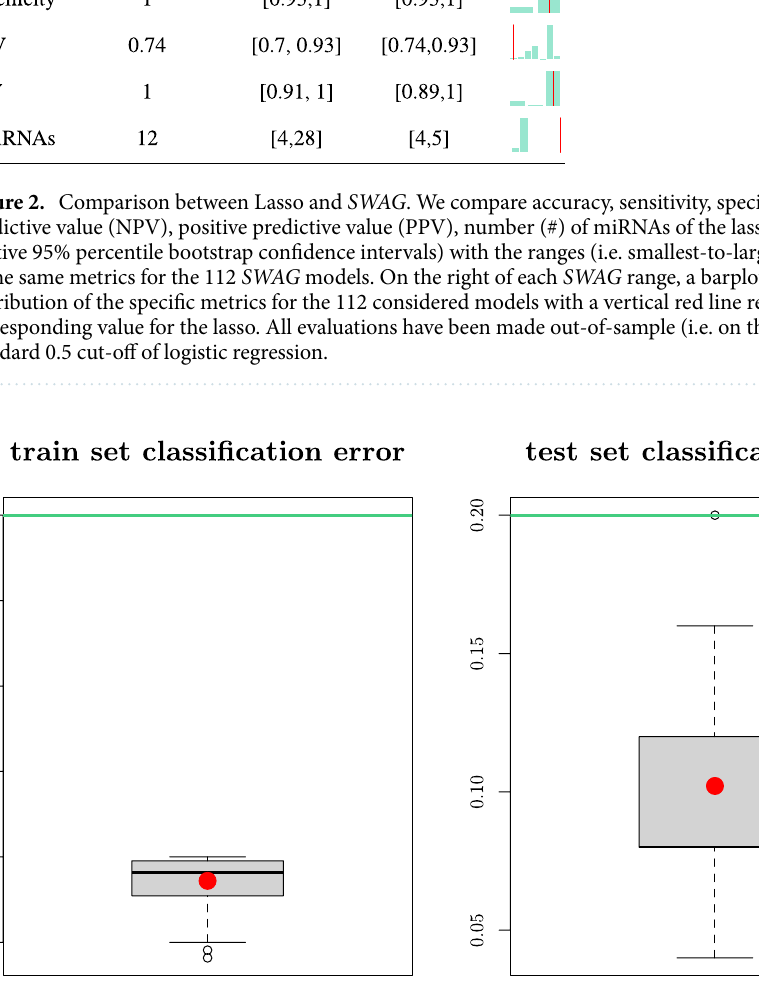
Figure 3. Train and test set classification error for SWAG . We compare the box plots of the train set and the test set cross-validation prediction error (i.e. classification error) for the 112 SWAG models. The red point inside each box plot represents the average classification error of the SWAG models either in the train set or in the test set. The horizontal green line in both plots, that we use as a reference level, represents the classification error of the lasso either in the train or in the test